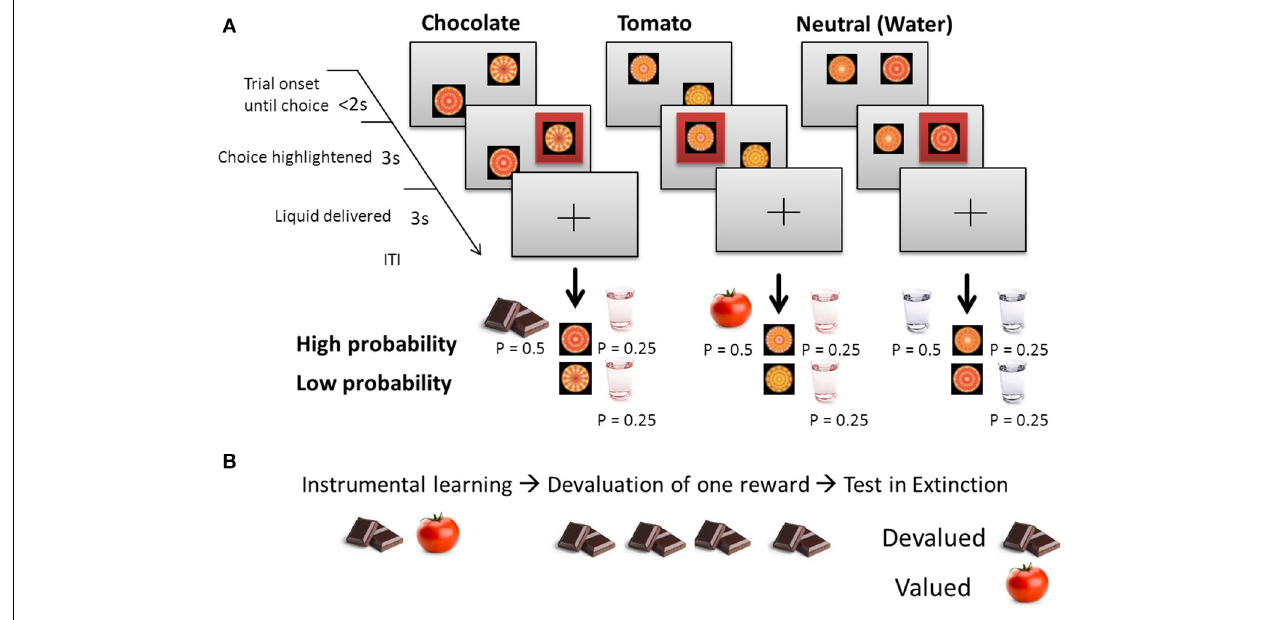
FIGURE 1 | Selective devaluation paradigm according to Valentin et al. (2007). (A) Trial structure depicted for each condition during instrumental learning. On each trial subjects had to choose between two abstract stimuli, the chosen stimulus is then highlighted. The high-probability stimulus choice leads to a food outcome (chocolate or tomato) with a probability of p = 0 . 5 and to a common outcome (fruit tea) with p = 0 . 25. The low-probability stimulus choice never leads to food outcomes and in p = 0 . 25 to the